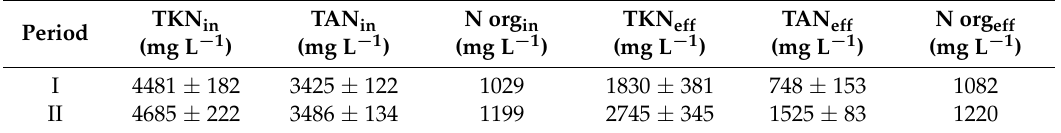
Table 2. Nitrogen mass balance for the system for Period I and Period